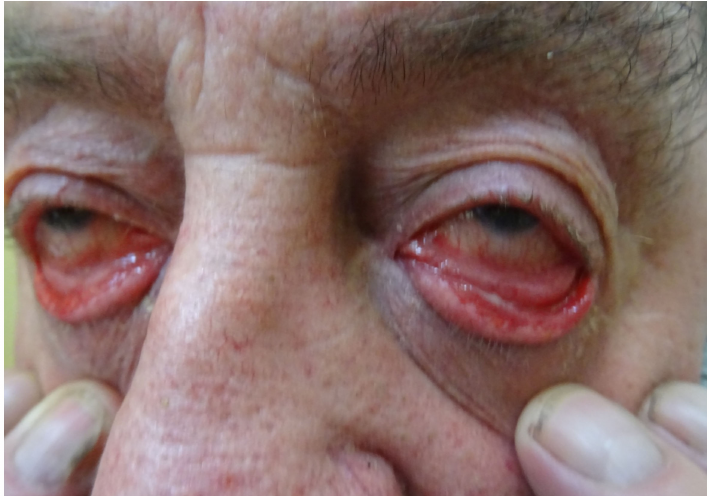
Figure 2. A 73-year-old man with an exacerbation of PV bilaterally involving mainly conjunctiva. Expression of the majority of desmosomal molecules in human conjunctiva is similar to the expression of DSGs in the middle of the epidermis [15]. DSG 3 is expressed on the entire ocular surface, including the cornea, bulbar, and palpebral conjunctiva [16]. Expressions of DSG 1 and DSG 3 are uniform in the cornea and sclera. DSG 3 is also expressed in deeper structures of the eye, like the retina